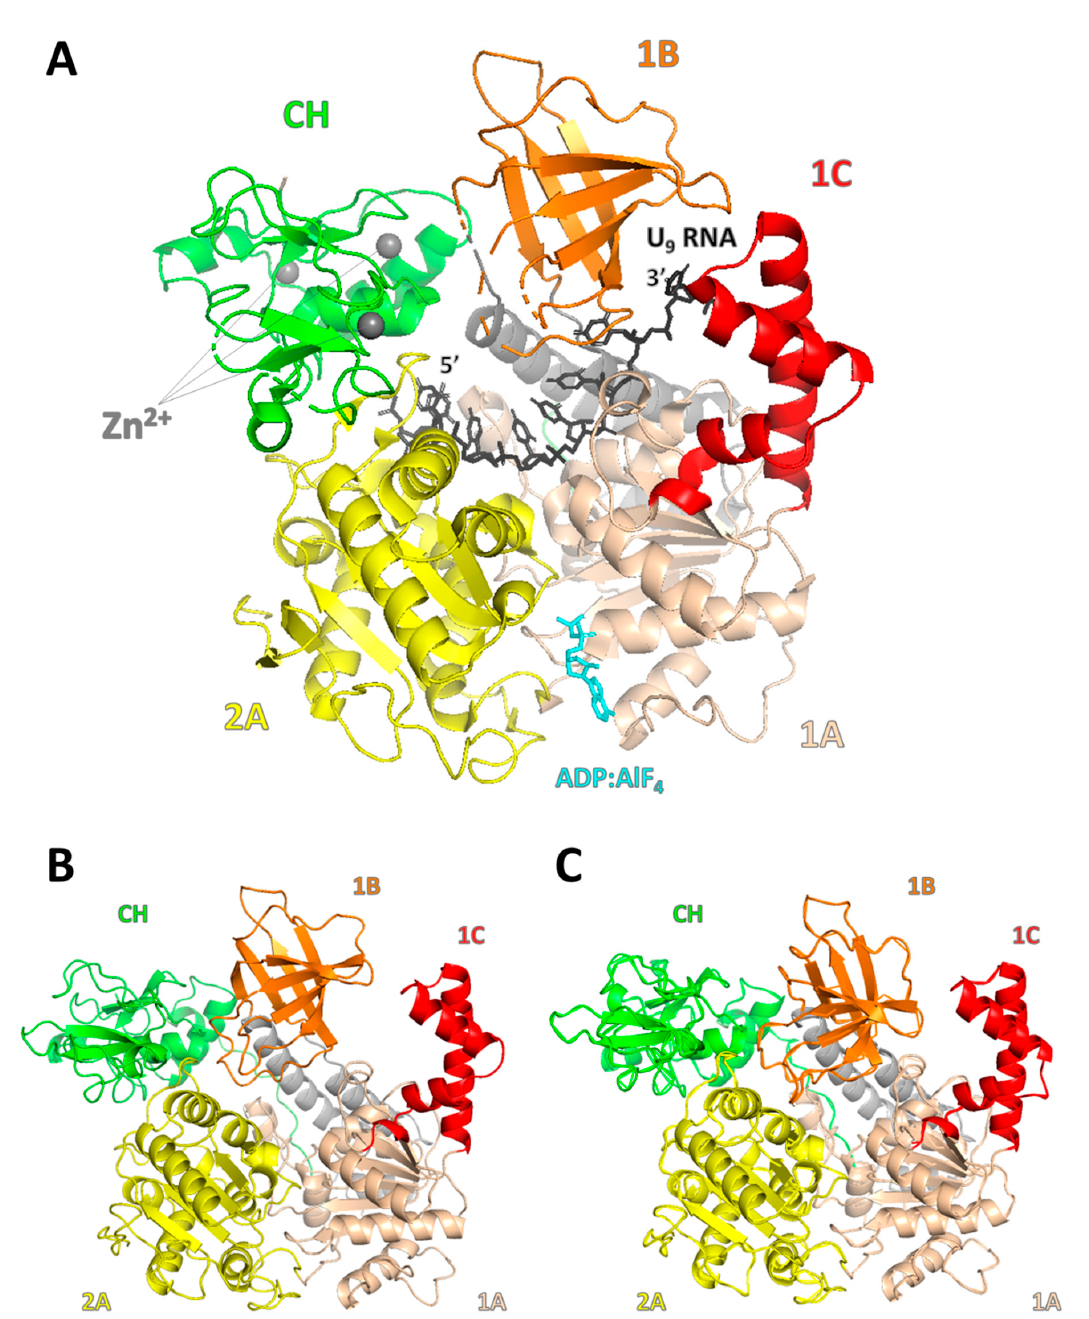
Figure 2. UPF1 protein helicase core structures. ( A ) Yeast Upf1 helicase core crystal structure in Upf1–RNA–ADP:AlF 4 complex (residues 61–850, structure accession code 2XZL—protein databank, [21]). RecA-like 1A domain in wheat, RecA-like 2A domain in yellow, CH-domain in green and regulatory subdomains 1B and 1C in orange and red, respectively. Represented as sticks: 9 bp long uracil-RNA (U 9 ) in black and ADP:AlF 4 (mimicking the transition state of the nucleotide in the ATPase cycle) in cyan. Zinc ions within the CH-domain structure are shown as gray spheres. AlphaFold predictions of ( B ) yeast Upf1 (residues 61–850) and ( C ) human UPF1 helicase core structure (295–914). Domains colored as mentioned above. All structure images were created in PyMOL.